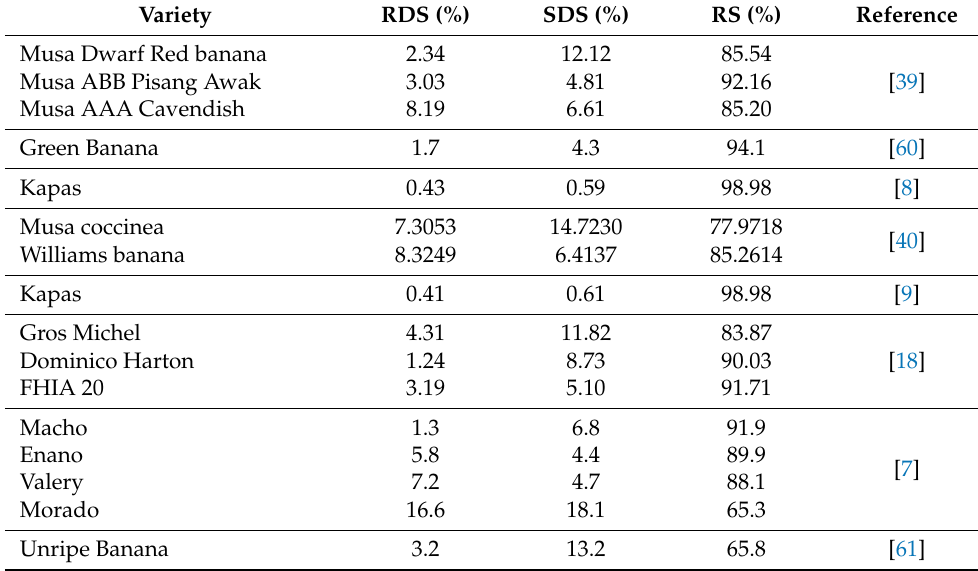
Table 6. Digestibility properties of banana